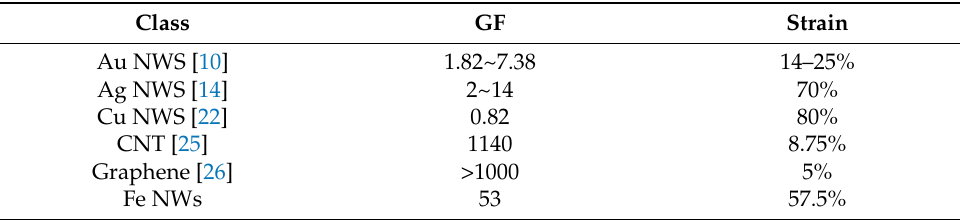
Table 2. Key performance of flexible tensile strain sensor based on nanowires.